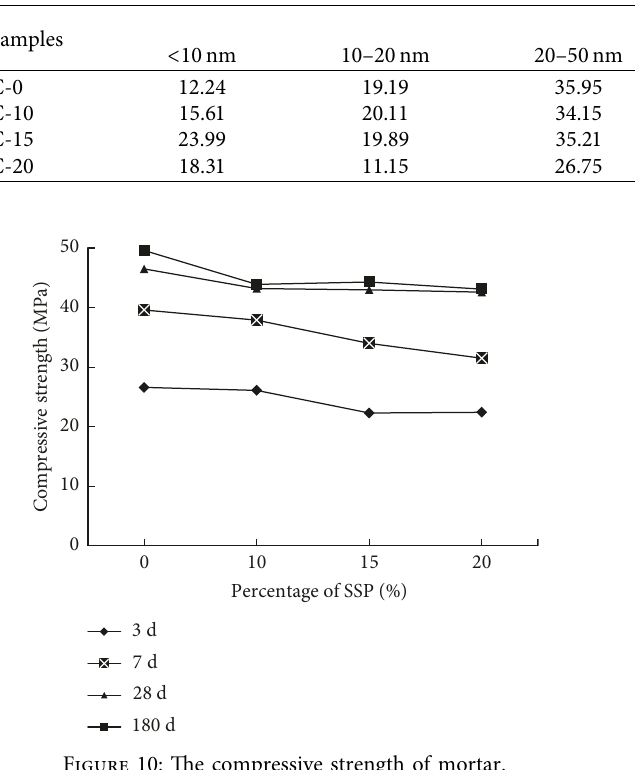
Table 5: The ratio of the pore size distribution (%).